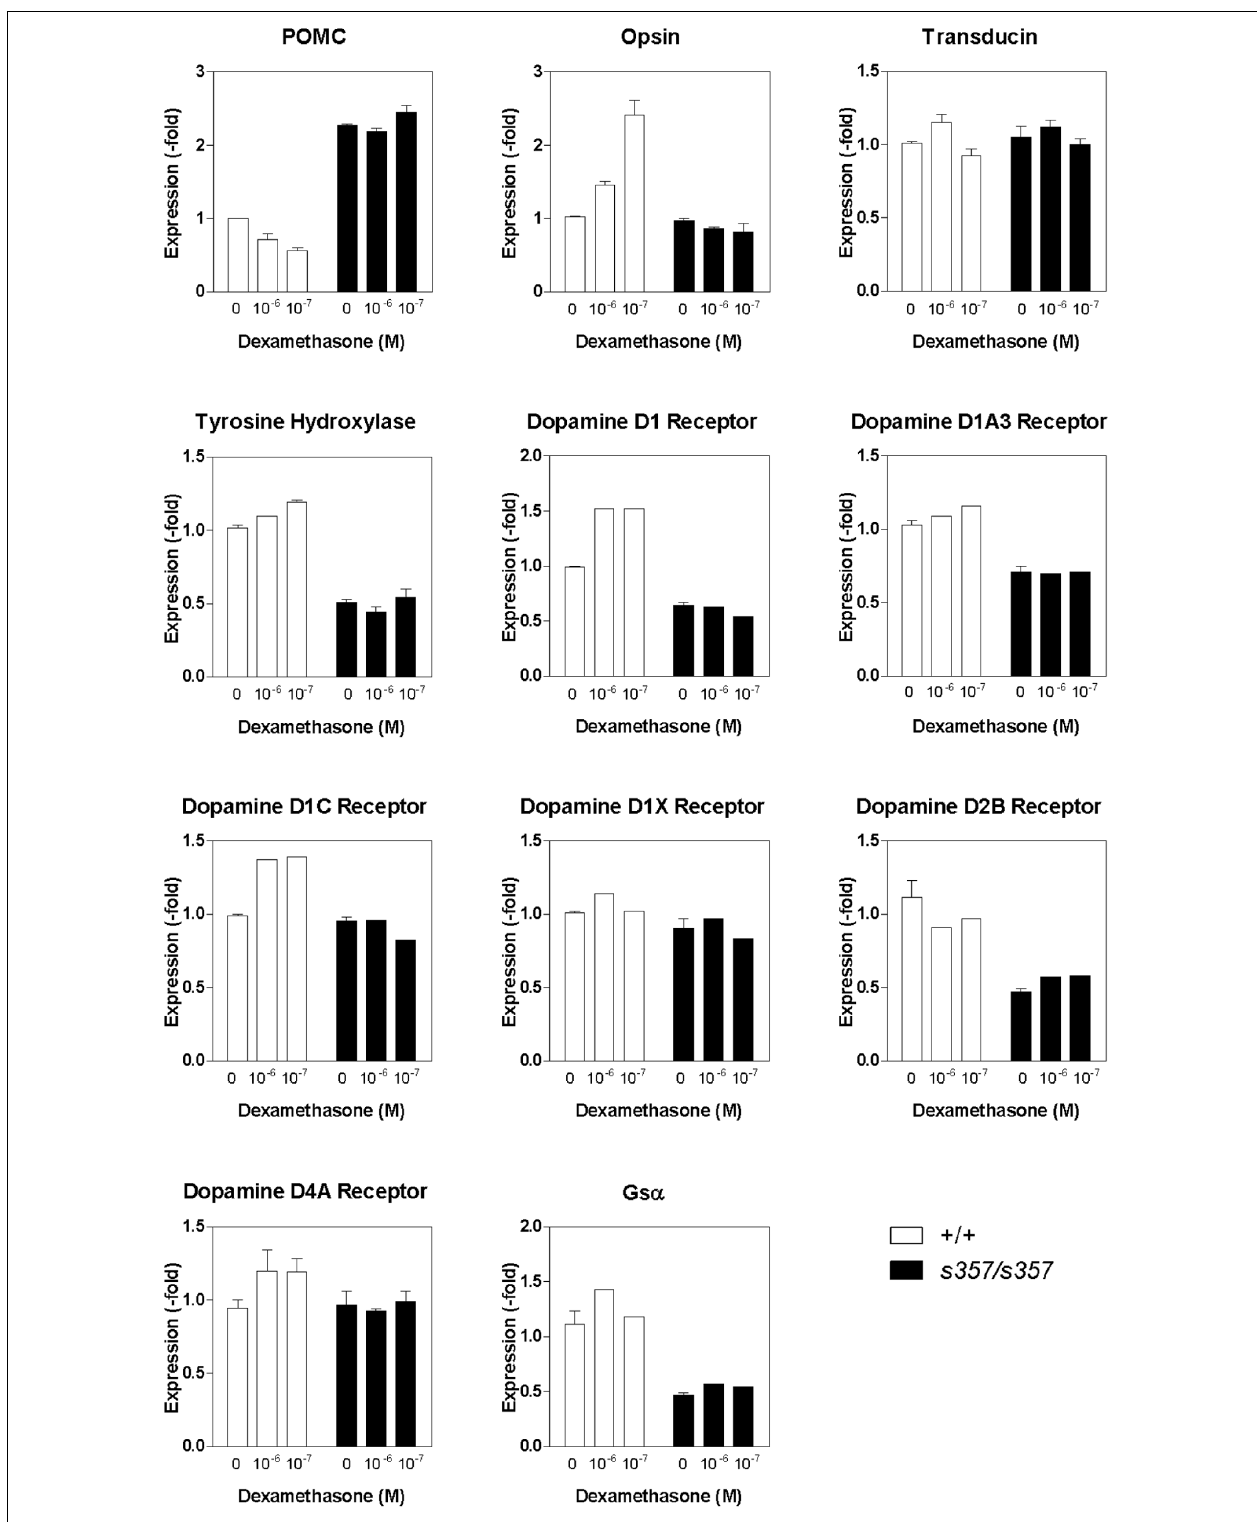
FIGURE 4 | Expression of vision-related genes in the gr s357 mutant as determined by real-time quantitative PCR. Dexamethasone (10 − 6 and 10 − 7 M) was bath-applied to 6 dpf fish.Vehicle (ethanol) was used as control. RNA was isolated 24 h later. Cyclophilin A was used as a control to which other gene expression levels were